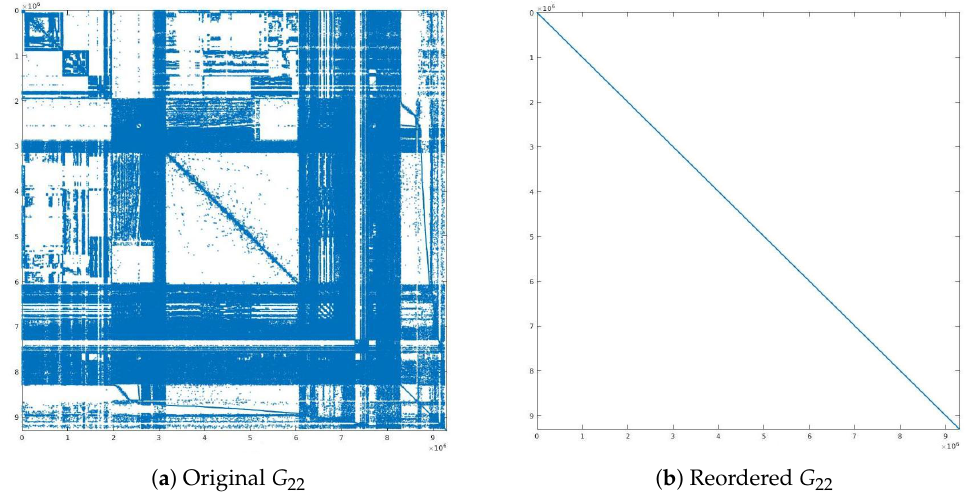
Figure 6. Sparsity of matrix G 22 and reordered G 22 using Reverse Cuthill-McKee (RCM).